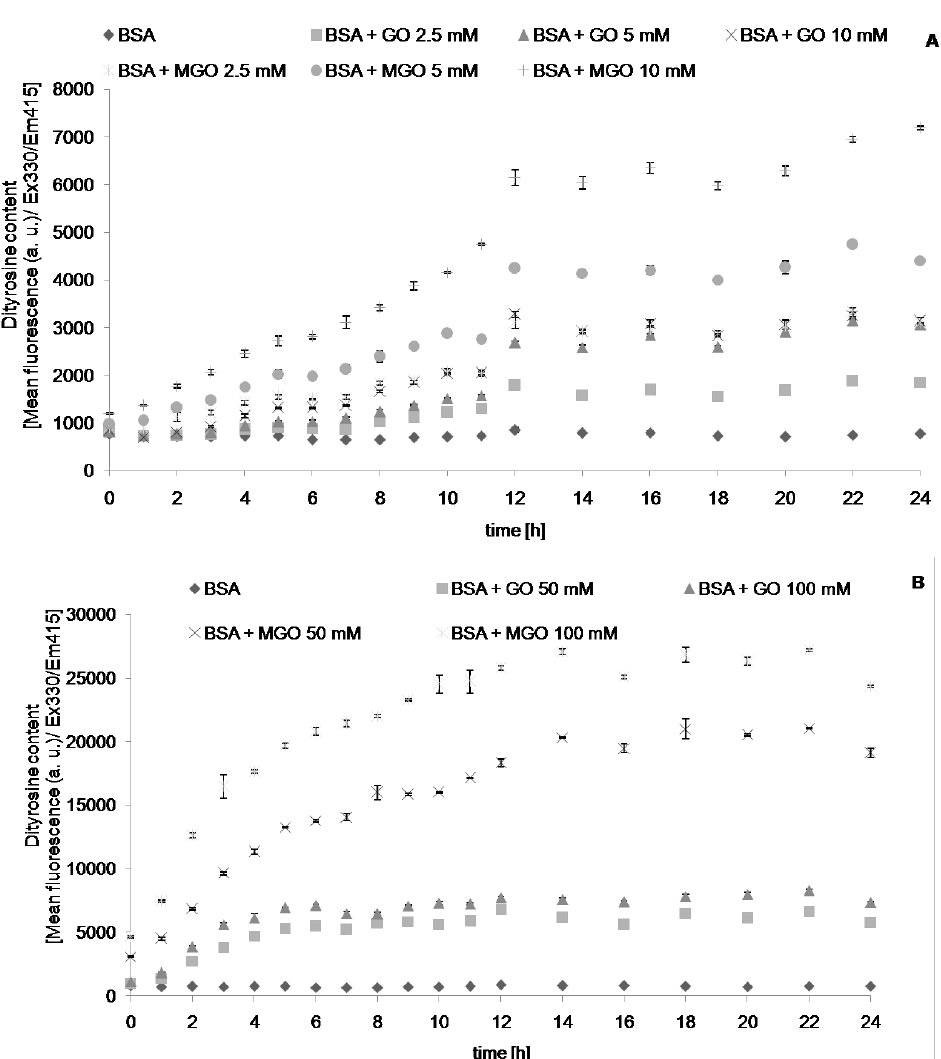
Figure 2. The time course of dityrosine fluorescence during incubation of BSA (0.09 mM) with 2.5, 5 and 10 mM ( A ), and 50 and 100 mM ( B ) GO and MGO at 37 °C.